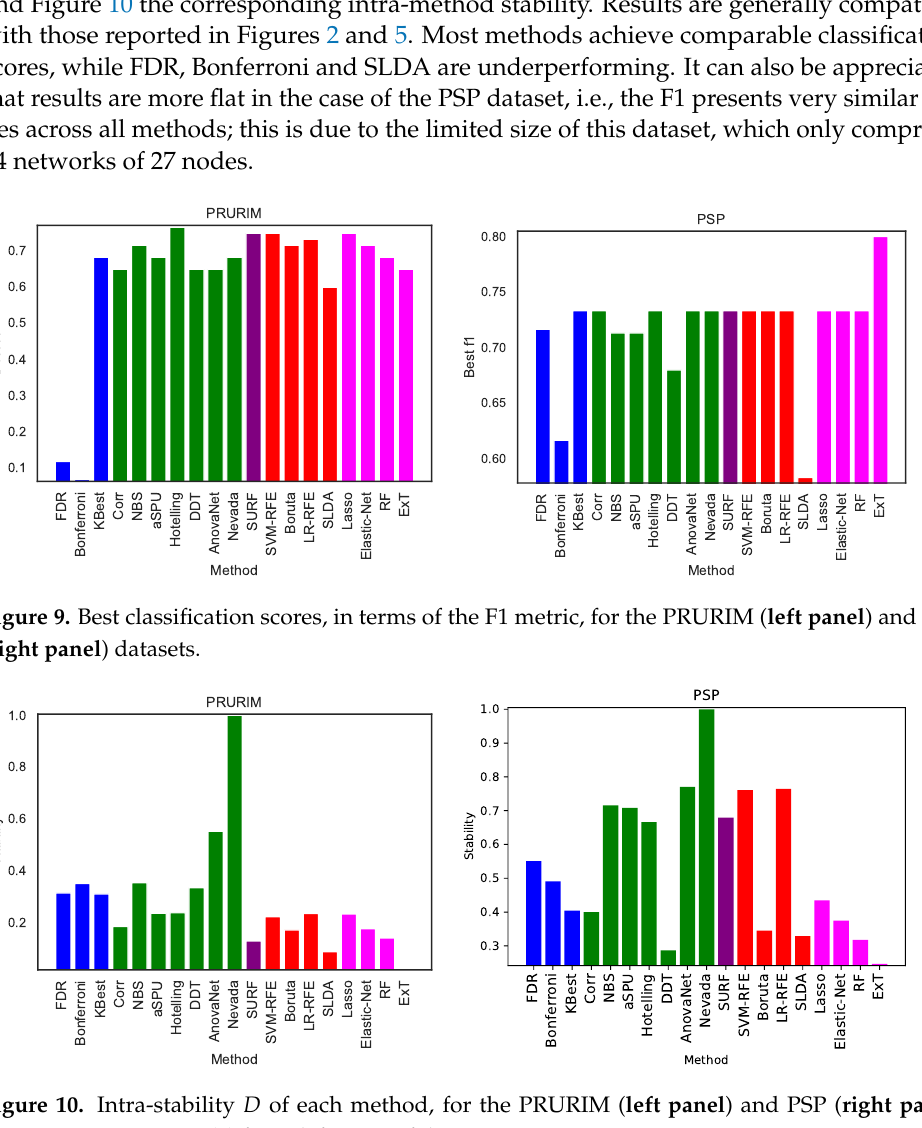
Figure 10. Intra-stability D of each method, for the PRURIM ( left panel ) and PSP ( right panel ) datasets. See Equation (3) for a definition of the metric D